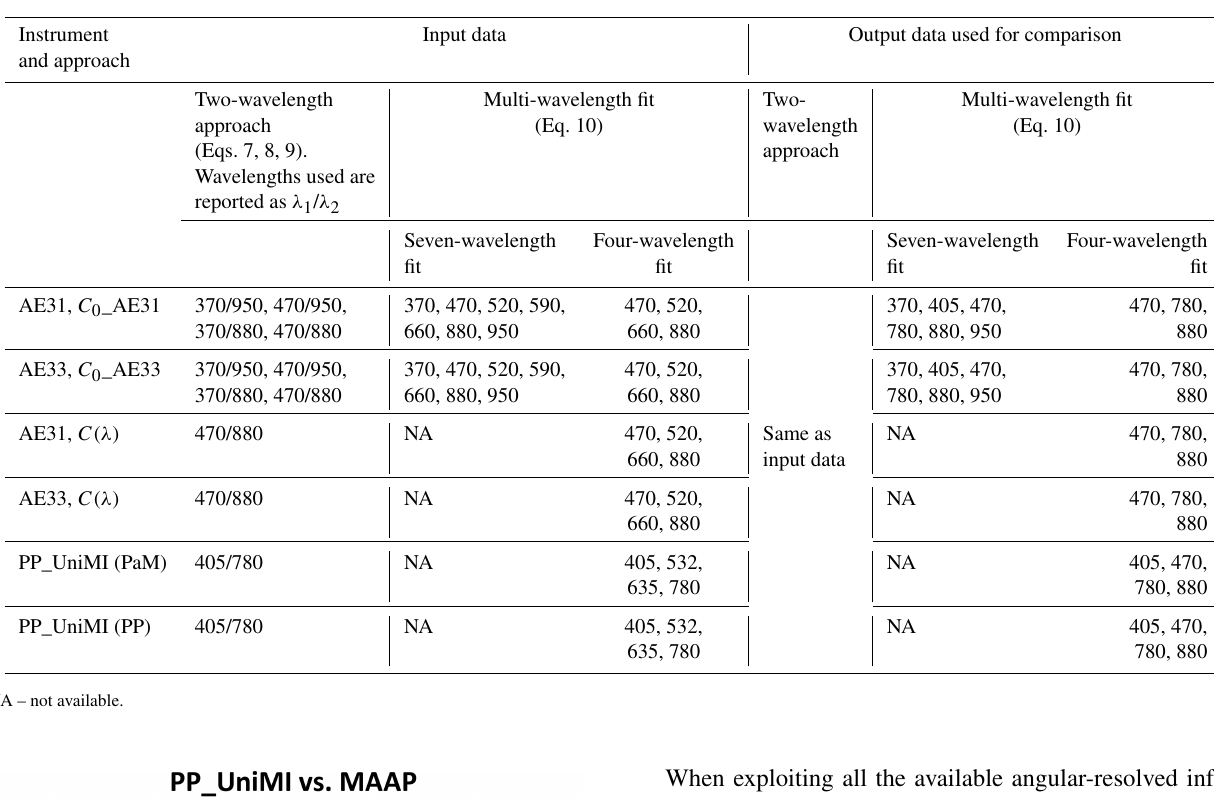
Table 1. Summary of the tests available for the Aethalometer model. For each instrument and approach to retrieve b abs and for each approach to the Aethalometer model, wavelengths (in nm) in input to model and reference wavelengths (in nm) for source apportionment used as output are reported.